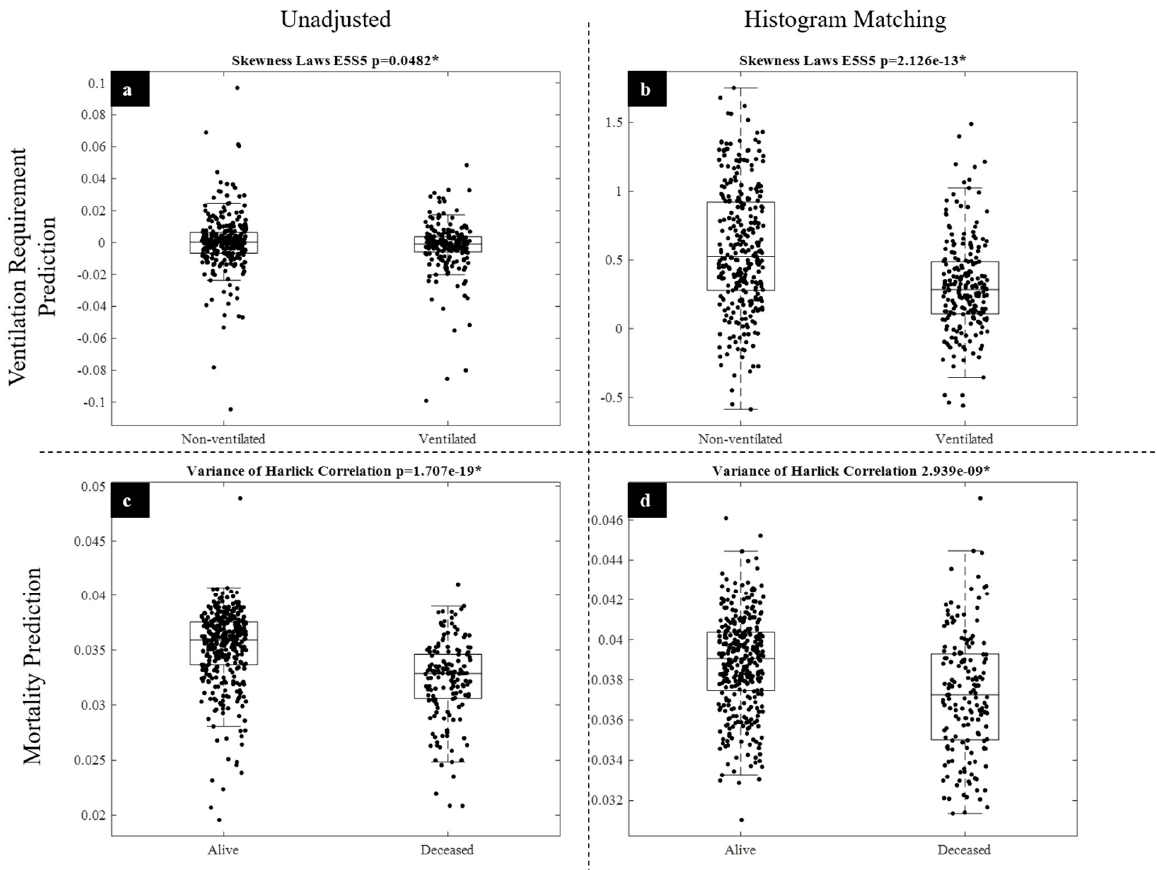
Figure 8. Radiomic feature distribution. Visualized are the relative effects of HM on the distribution of highly discriminative features for ventilation requirement and mortality prediction. ( a , b ) visualize the distribution of the skewness of the Laws E5S5 radiomic feature for ventilated and non-ventilated patients before ( a ) and after ( b ) HM. ( c , d ) display the distribution of the variance of the Haralick Correlation for alive and deceased patients before ( c ) and after ( d ) HM.